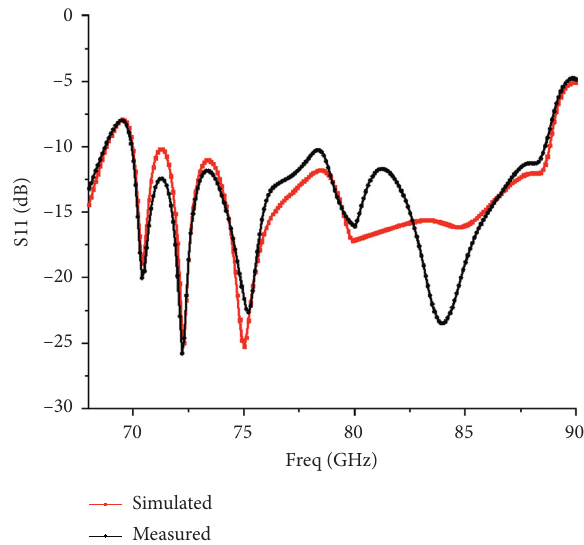
Figure 15: Simulation and measurement results of the return loss of the antenna array.